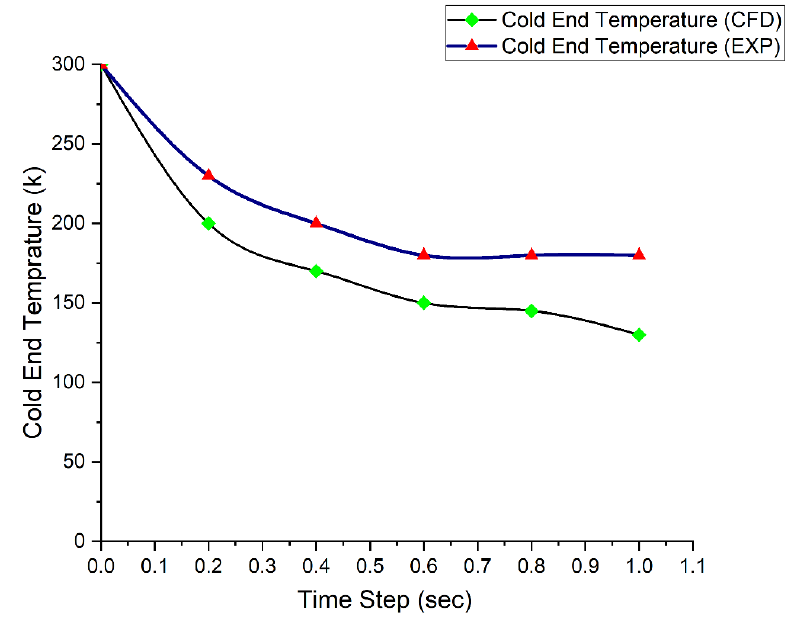
Figure 11. Comparison of cold-end temperature of DIPTR with time step for case 1.